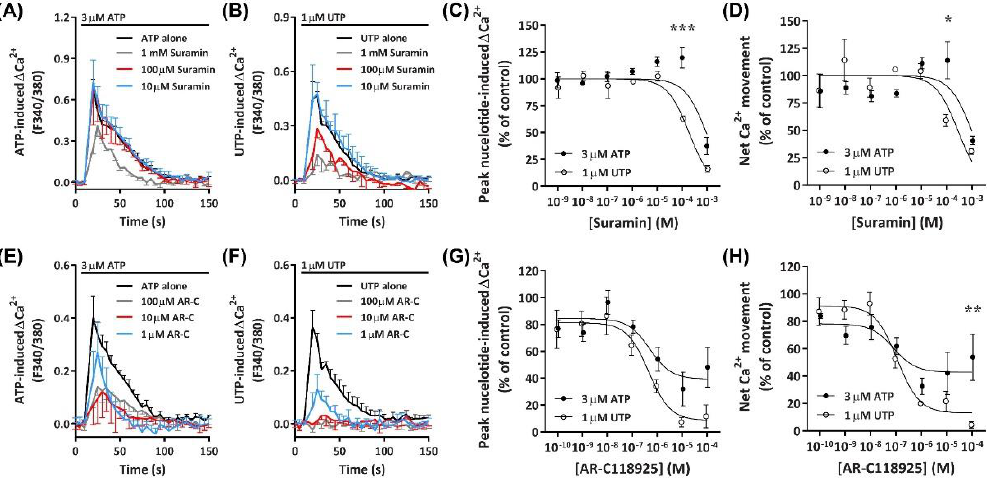
Figure 8. ATP- and UTP-induced Ca 2+ responses in DH82 cells in the absence or presence of suramin or ARC-118925. ( A – H ) DH82 cells in ECS were loaded with Fura-2 and preincubated in the absence or presence of increasing concentrations of ( A – D ) suramin (in ECS) or ( E – H ) AR-C118925 (AR-C; 0.3% DMSO) for 30 min. Cells were then exposed to 3 µM ATP or 1 µM UTP (respective EC 80 values) and Fura-2 fluorescence was recorded. Nucleotide-induced ( C , G ) peak Ca 2+ response and ( D , H ) net Ca 2+ movement were normalised to 3 µM ATP or 1 µM UTP alone and expressed as a percentage of the response in absence of inhibitor (% of control). Data were then to fit data to the Hill equation to produce concentration-response curves and calculate the IC 50 . ( A – H ) Data shown are mean ± SEM from three independent experiments. * p < 0.05, ** p < 0.01 and *** p < 0.001 compared to respective concentration of antagonist with ATP or UTP analysed using a two-way ANOVA with Bonferroni post hoc test.